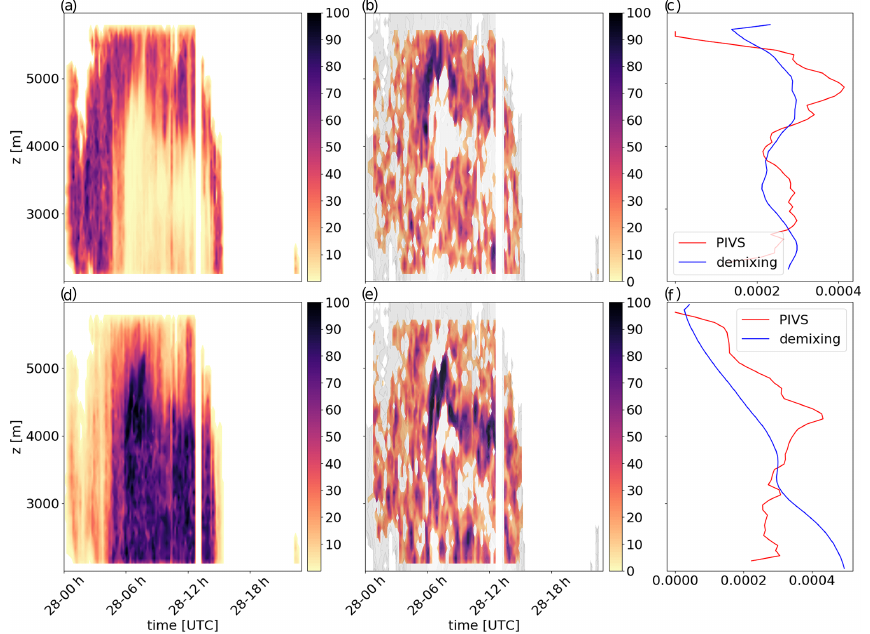
Figure 6. Same as Fig. 5 for